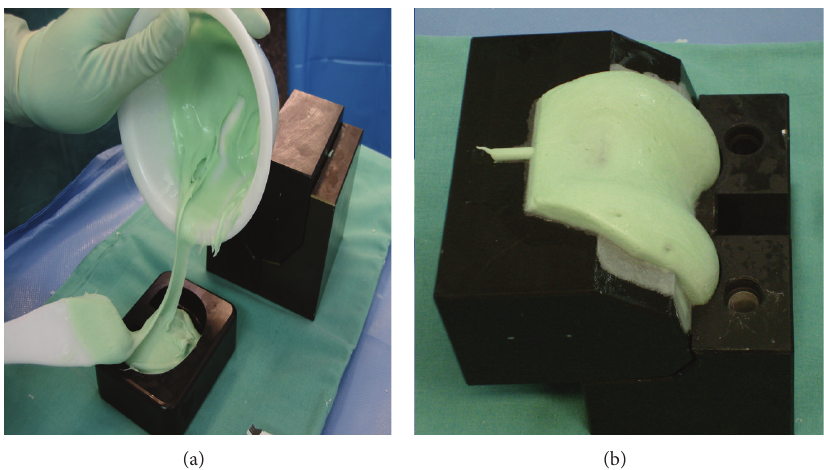
Figure 2: (a) Tibial mold, (b) femoral mold used intra-operatively.